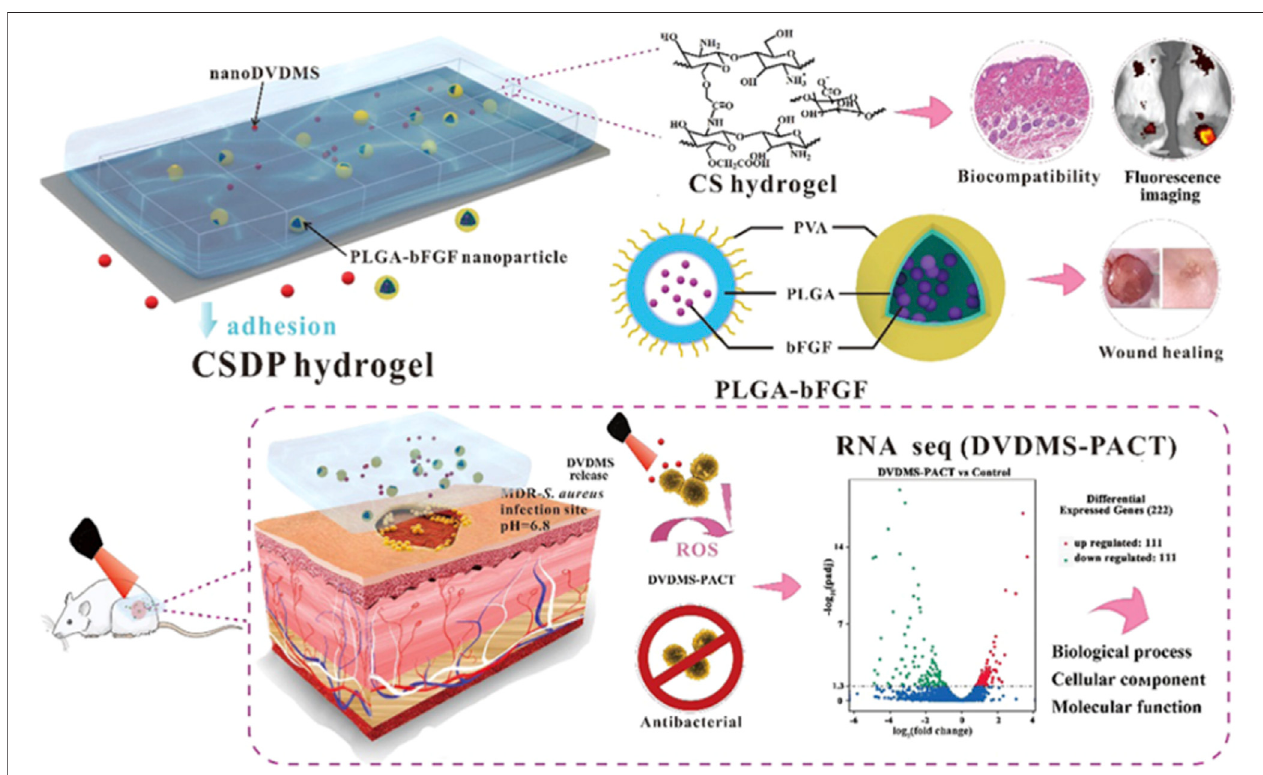
FIGURE 7| Schematic representation of the multifunctionalities of the hydrogel; with improved bioavailability, there ’ s improved reduction in bacteria and improved wound healing. Adapted with permission from Mai et al. (2020).